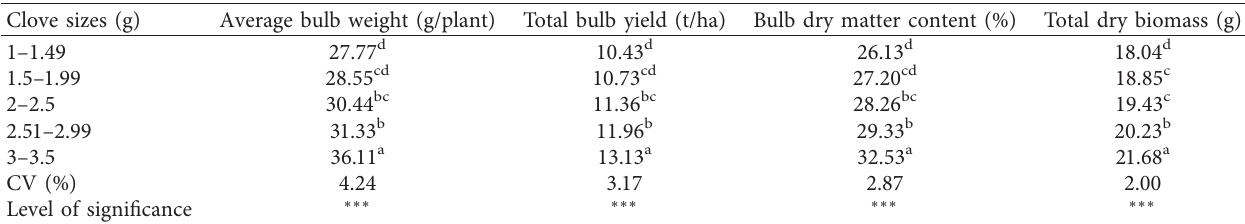
Table 4: Average bulb weight, total bulb yield, bulb dry matter content, and total dry biomass as influenced by the effect of clove sizes. Clove sizes